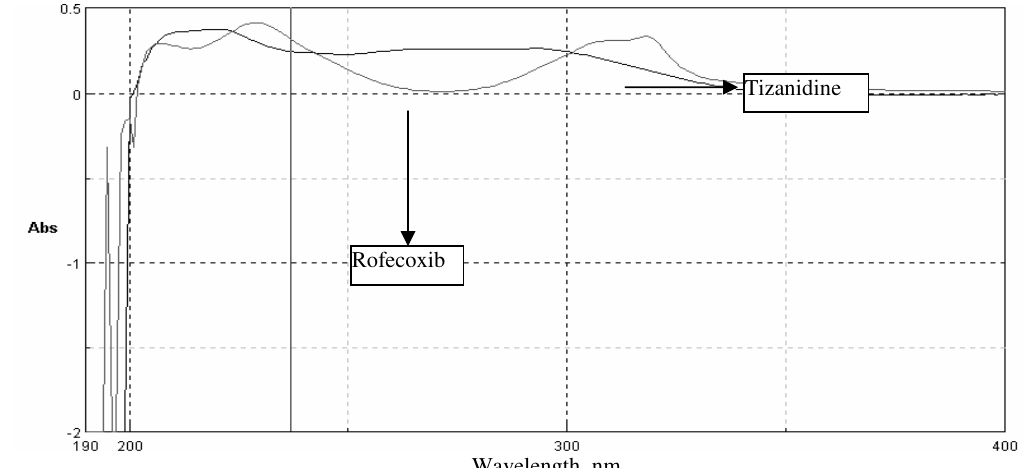
Figure 2. Overlay UV spectra of a) Rofecoxib and b) Tizanidine in